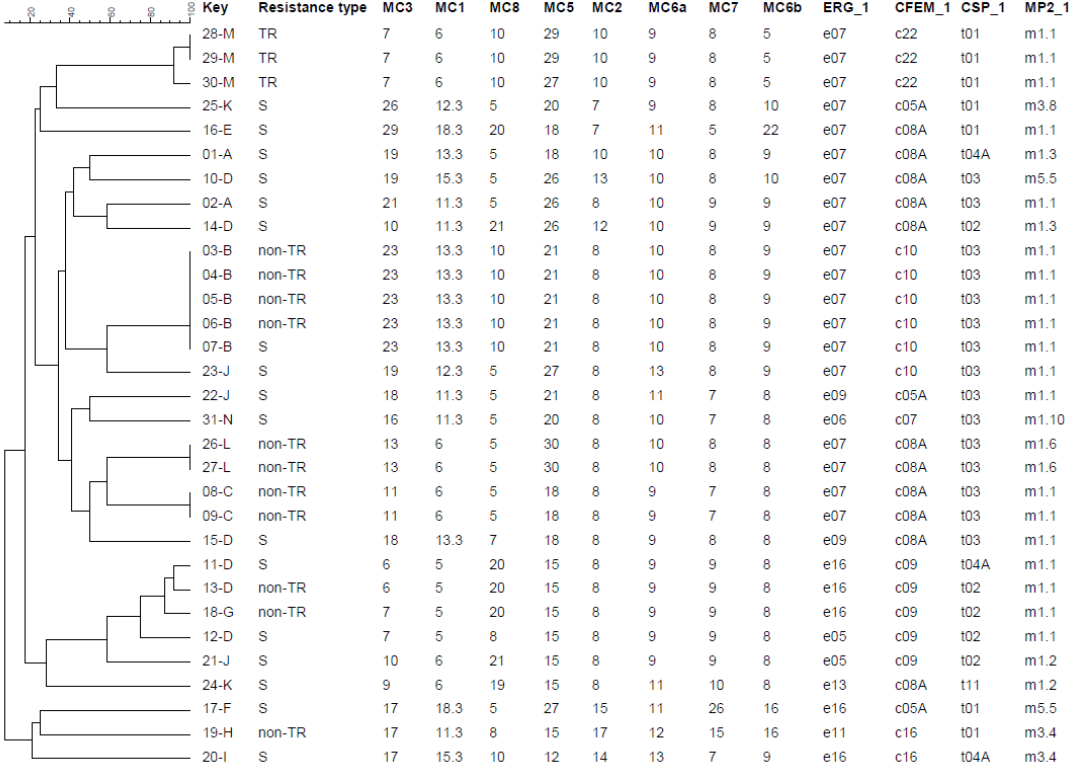
Figure 1. Dendrogram of 29 clinical chronic pulmonary aspergillosis (CPA) and 2 reference isolates. MC3-MC6b were the 8 markers of the nSTR Af method [40]. ERG_1-MP2_1 were the 4 markers of the TRESPERG method [55]. TR represents tandem repeat in the cyp51A gene and non-TR represents resistance types other than tandem repeat, while S represents triazole-sensitive (itraconazole, voriconazole, posaconazole, and isavuconazole were tested using the EUCAST method [134]). More than three isolates per patient were analysed in four of fourteen patients, designated by unique capital letters.